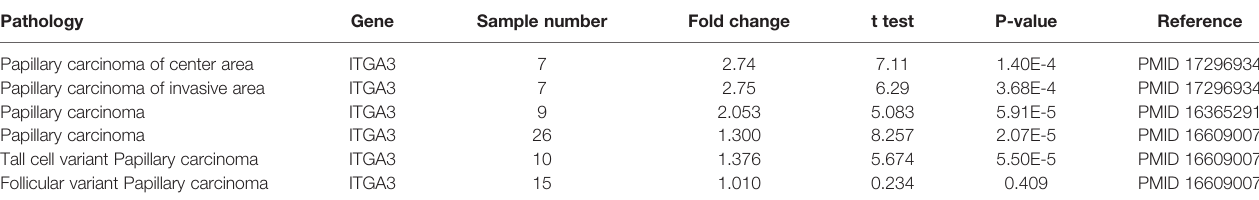
TABLE 1 | ITGA3 expression in PTC in Oncomine